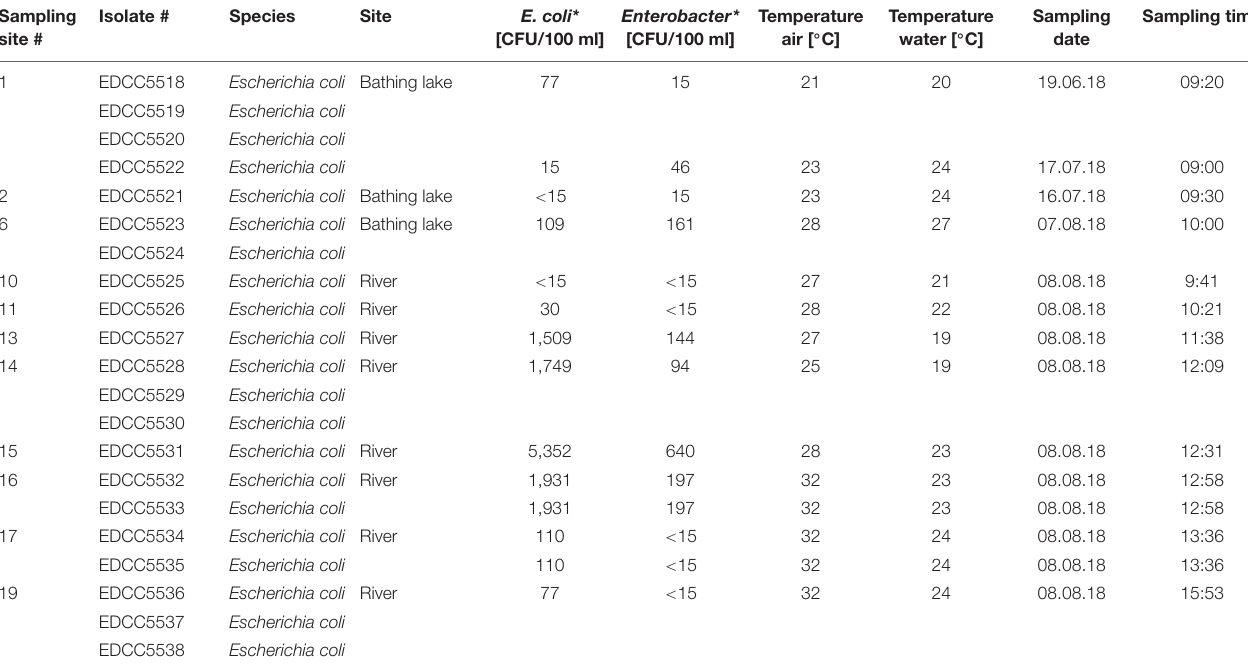
TABLE 1 | Environmental data and enumeration results of sampling sites with ESBL-positive samples. Sampling site